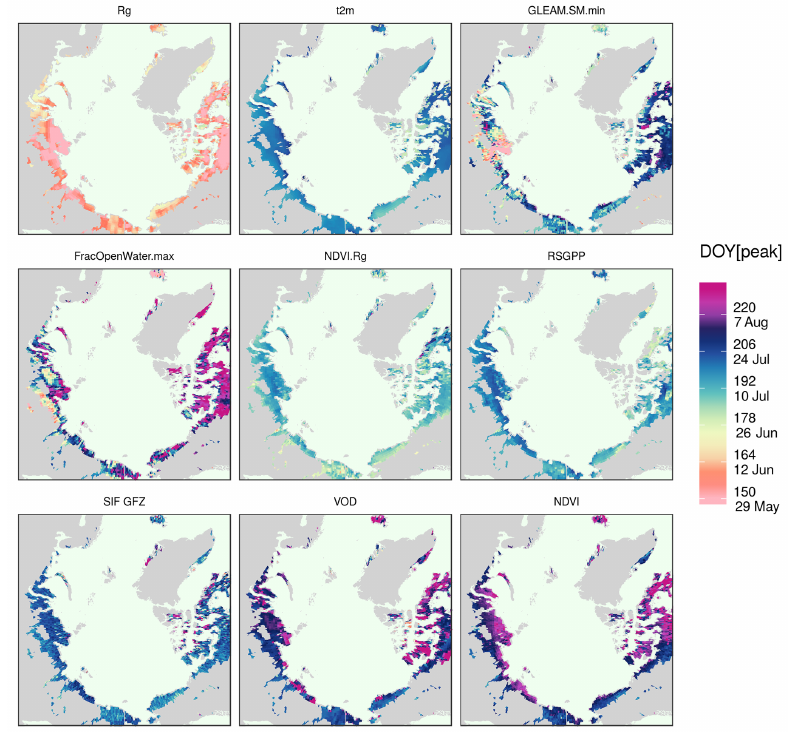
Figure 5. DOY of the annual maximum averaged over all years, as indicated by selected vegetation